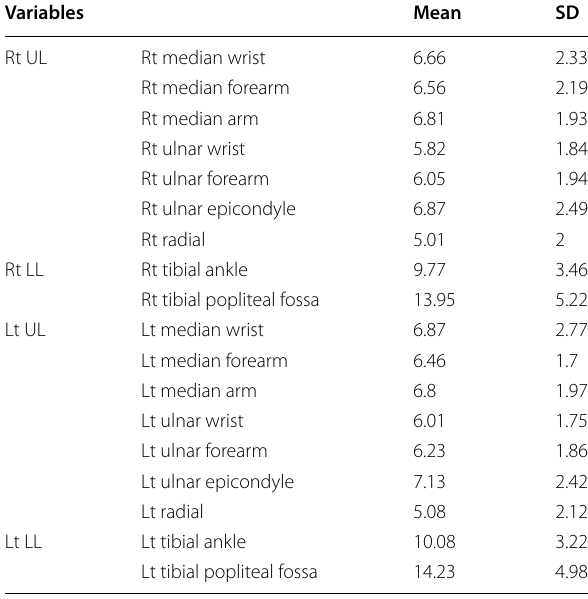
This table shows that the mean value of each neuro-sonography variable measured by mm 2